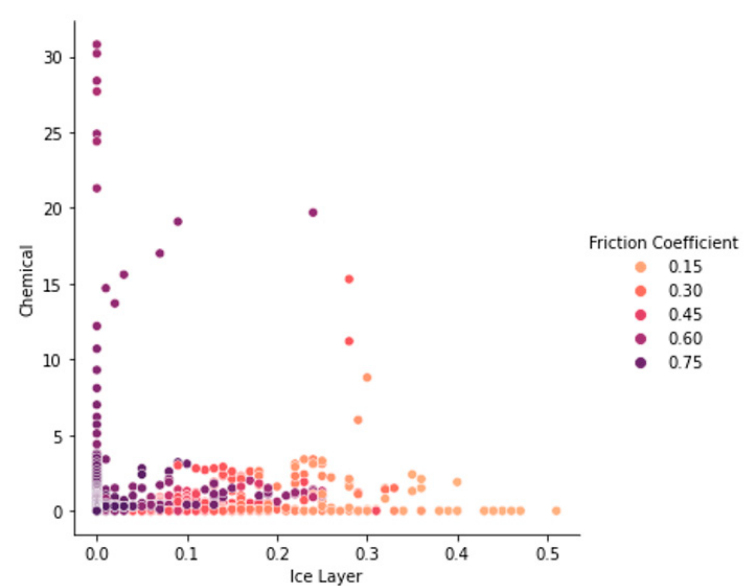
Figure 11. Scatter plot for the ice layer, chemicals, and RSFC.